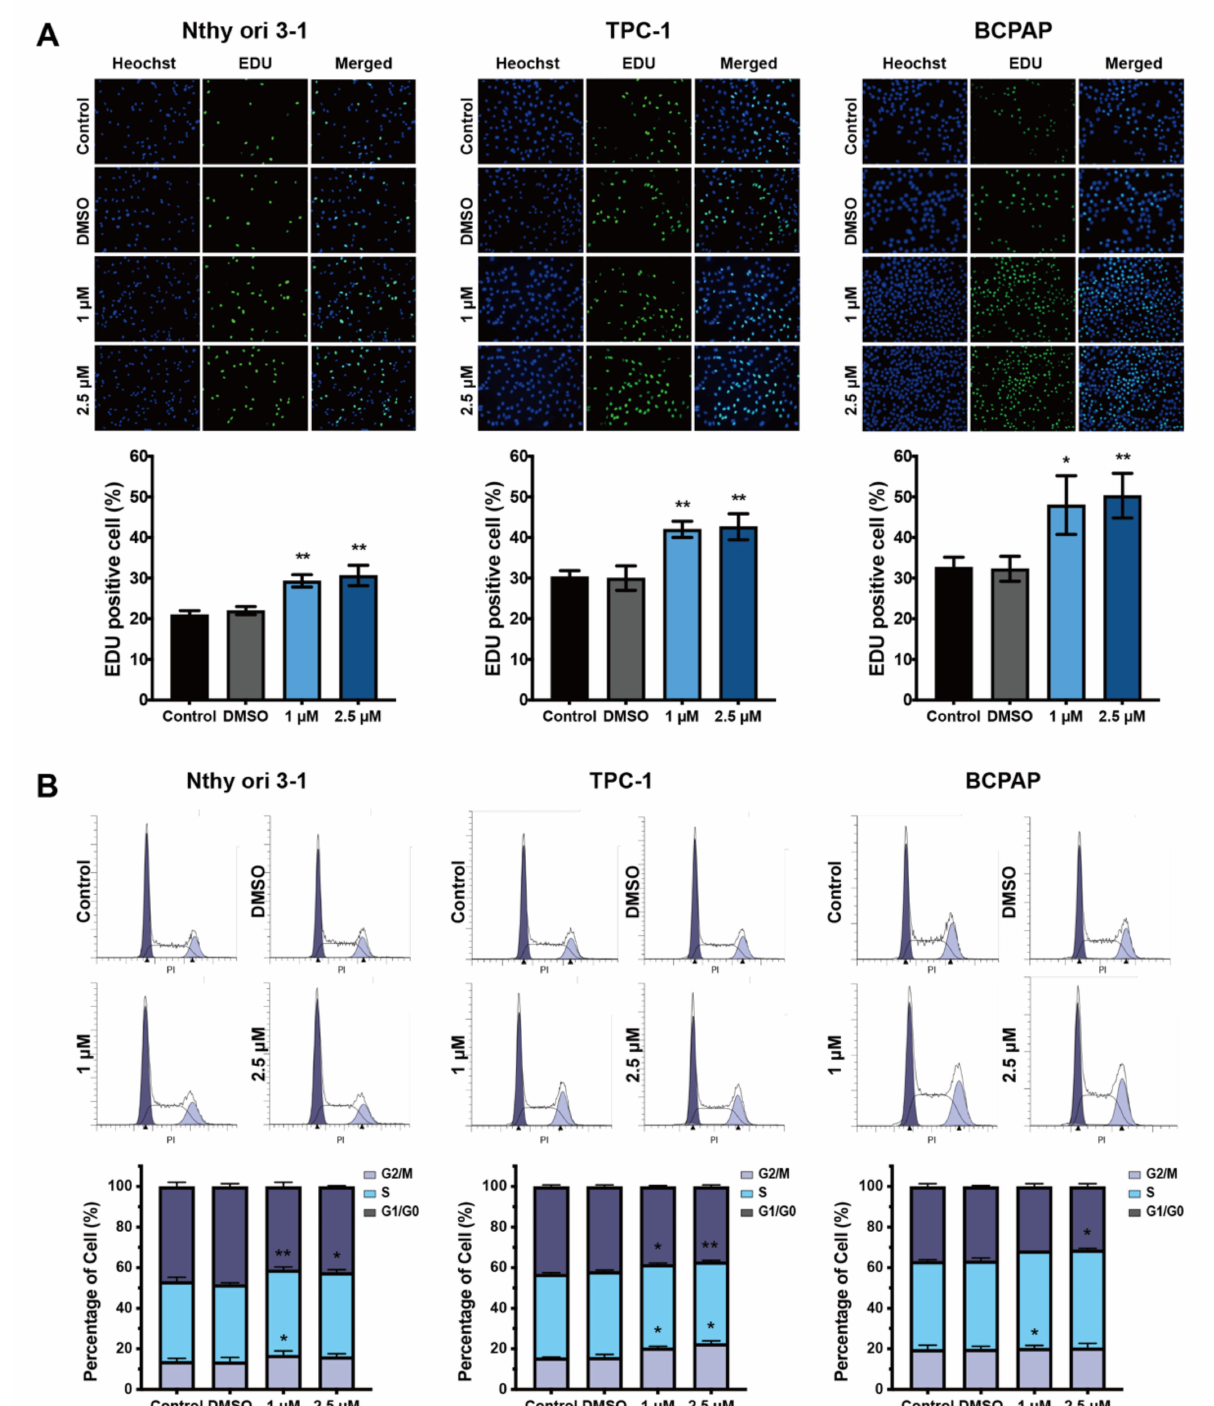
Figure 2. Cell cycle analysis of Nthy-ori 3-1 and PTC cells after exposure to BDE209 (1 and 2.5 µ M). ( A ) Representative images (top panel) and quantitative results (bottom panel) of EdU assays of Nthy-ori 3-1, TPC-1 and BCPAP cells. ( B ) Percentages of the cells in the cycle phase of the flow cytometry analysis after treatment with BDE209 or DMSO. * p < 0.05; ** p < 0.01. Each experiment was repeated at least three